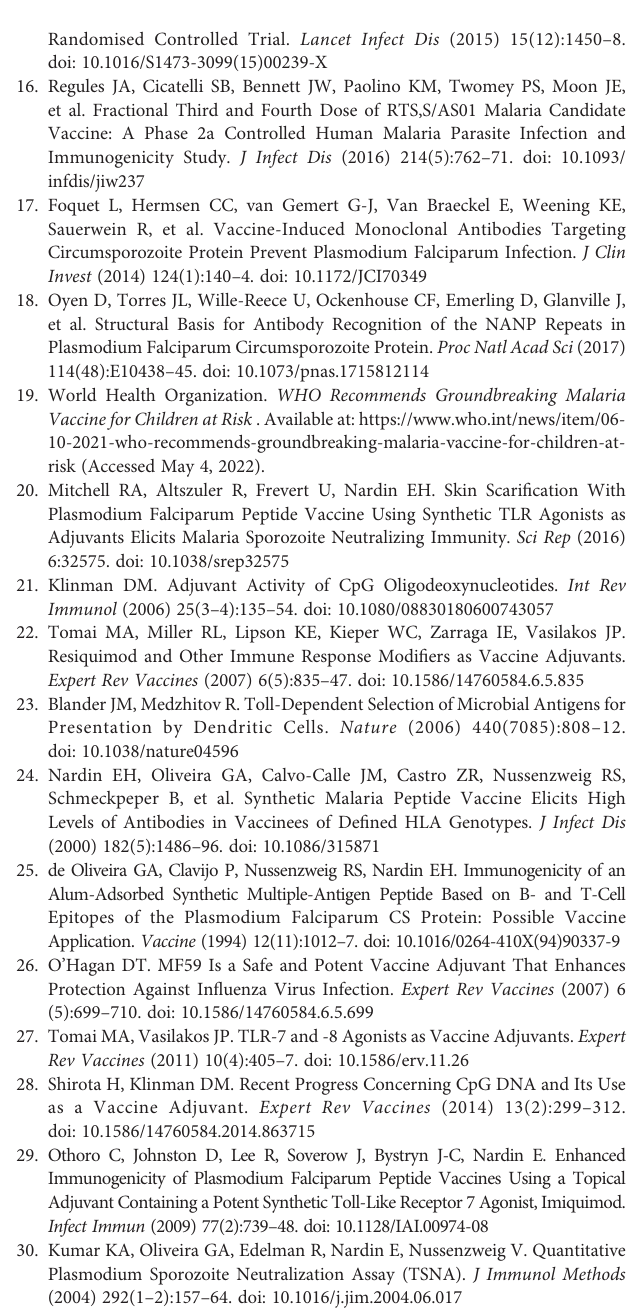
compared to WT mice (blue bars) at 4h post SS with CS peptide in PBS, Addavax, or Addavax + Resiquimod + CpG. Supplementary Figure 4 | Anti-repeat antibody response in hyperimmunized IP- 10 -/- mice. (A) IgG isotypes measured in CS repeat peptide ELISA using pooled hyperimmune serum (1:5120 dilution) from IP-10 -/- mice obtained 14d post the fourth SS immunization. (B) Kinetics of anti-CS repeat IgG antibody measured by ELISA in serum of IP-10 -/- mice collected at 14d post each of four SS immunizations (arrows). Signi fi cant difference was found after SS immunization with CS peptide in AddaVax + Resiquimod + CpG compared to AddaVax only by Mann- Whitney test post 2nd dose (*p=0.0238), post 3rd dose (**p=0.0079), and post 4th dose